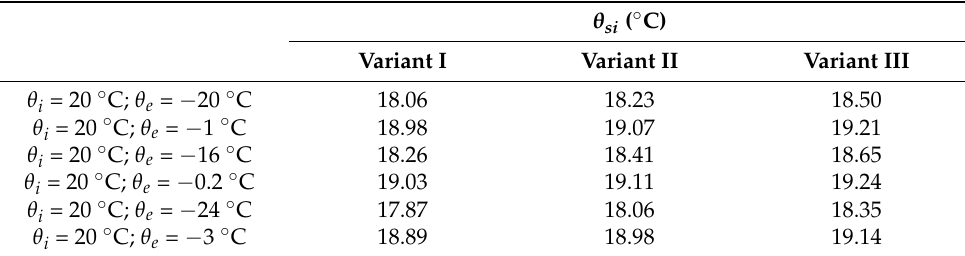
Table 12. The results of the simulation of the surface temperature of the wooden roof in three analyzed variants.